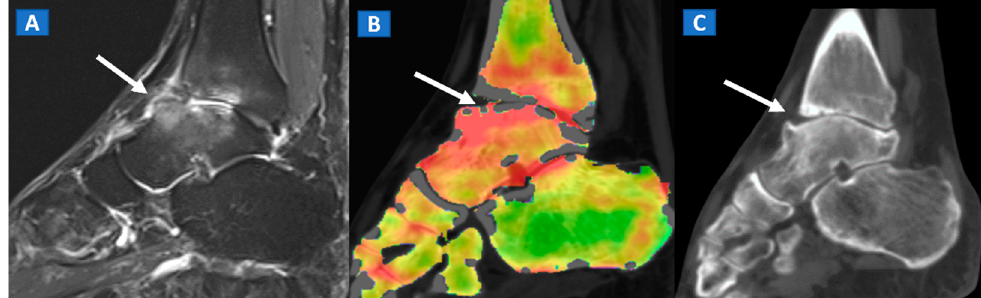
Figure 3. A 48-year-old male with OCL of the talar dome and distal tibia. On the sagittal STIR MRI image ( A ), subchondral marrow lesions, associated with thinning articular cartilage, are depicted on the talar dome and distal tibia (arrow). On the corresponding sagittal 1 mm DECT map ( B ), BME is depicted in red (arrow), whereas normal bone is shown in shades of green-yellow. On the sagittal 1 mm reconstructed CT image with a soft tissue window ( C ), it is possible to identify an astragalic beak, subchondral sclerosis and articular space narrowing (arrow) as being the probable causes of non-traumatic BME.